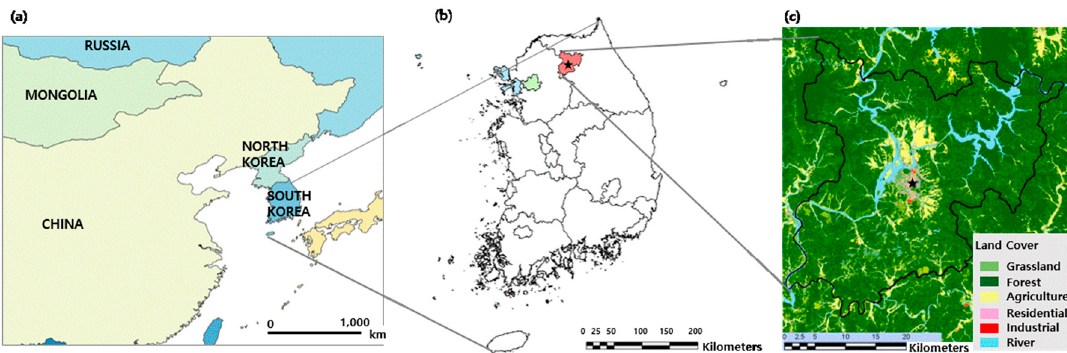
Figure 1. Study area. ( a ) Location of South Korea. ( b ) The sampling site location is indicated by the black star in the red area representing the city, Chuncheon and the metropolitan region (Seoul) and major industrial regions (Incheon) are shown as green and blue areas, respectively. ( c ) Land cover data for the city, Chuncheon. The sampling site location is also indicated by the black star.